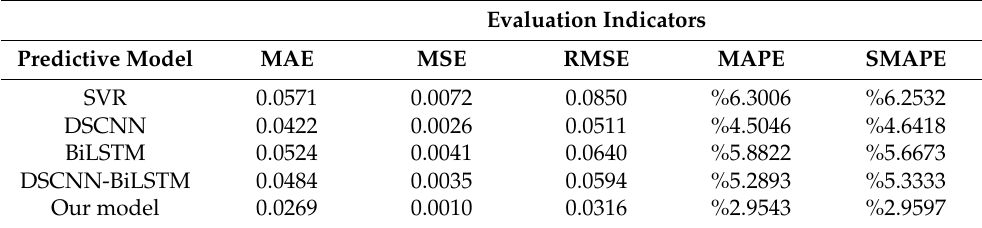
Table 4. Prediction performance indicators of different models.